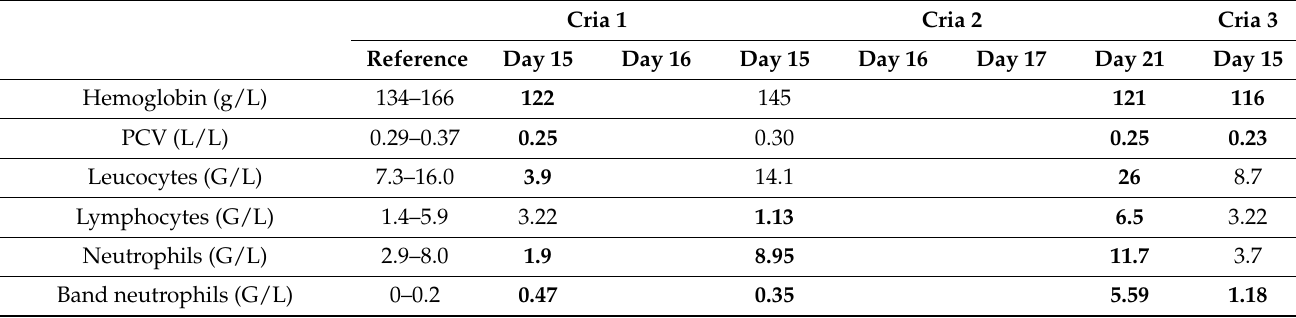
Table 2. Clinical chemistry of the initial and following plasma samples for cria 1 and cria 2. Analysis was performed with heparinized plasma. For the missing boxes, no data were available. Reference values derive from Dawson et al. [33] for clinical chemistry and Hengrave Burri et al. [34] for haematology, except for normoblasts, the reference values of which derive from Dawson et al. [35]. The reference value for 25-OH vitamin D was adopted from Gerspach et al. [22]. Values that differ from the references are displayed in